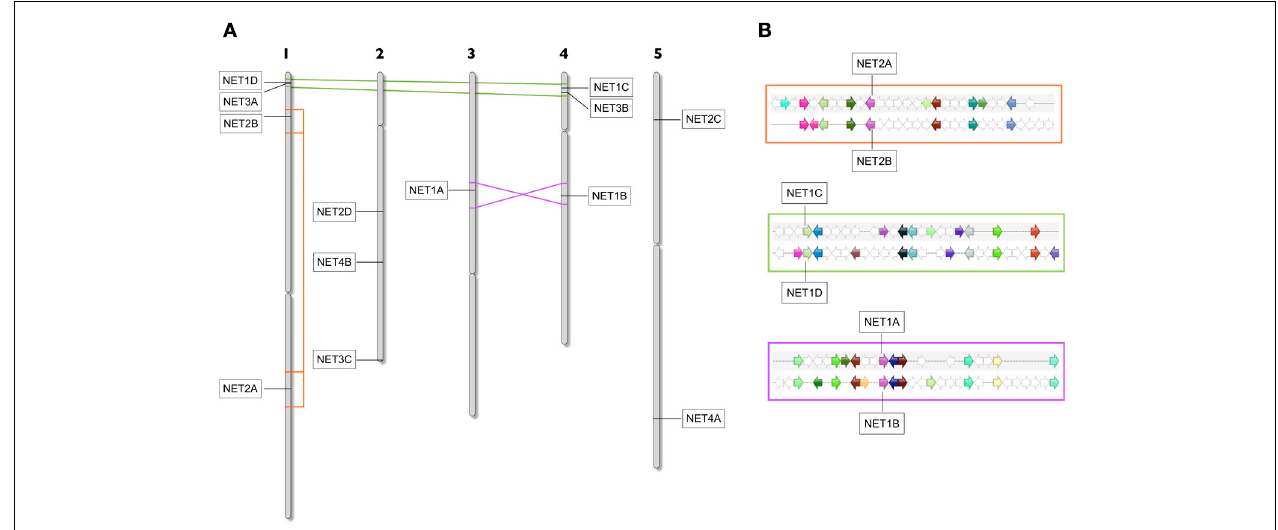
FIGURE 4 | (A) Arabidopsis chromosome schematic showing areas of duplication which contain Arabidopsis NET genes. Duplication between Chr1 and 4 contain NET1D/NET3A and NET1C/NET3B. Duplication and inversion